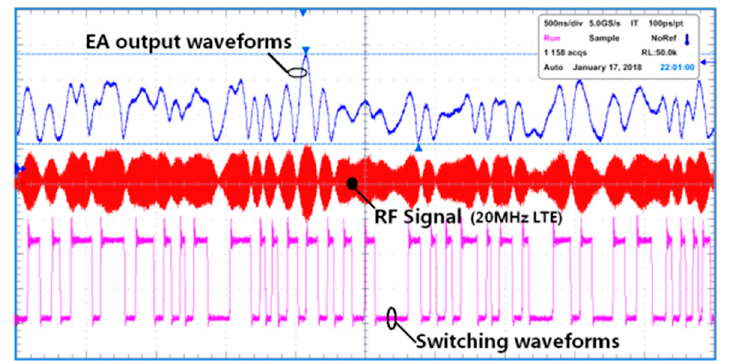
Figure 10. Representative waveforms of the ET experimental system.